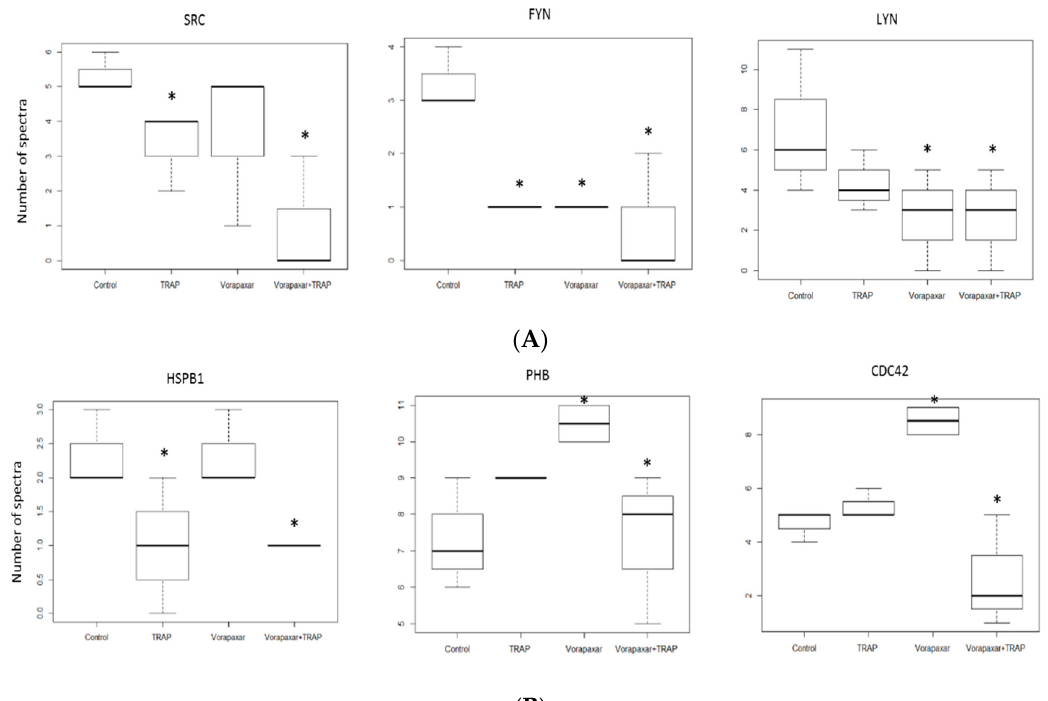
Figure 5. Proteomic analysis of Akt and MAP kinase signaling pathways. ( A ) Akt proteomic analysis showed significant differences in expression level of SRC, FYN, and LYN. * p < 0.05 according to one-way ANOVA test. ( B ) Proteins participating in MAP kinase pathway which showed significant difference between different experimental groups. * p < 0.05 according to one-way ANOVA test. Number of spectra: visualized spectra used to identify peptides and proteins by the X!Tandem search engine. Src: proto-oncogene tyrosine-protein kinase; HSPB1: heat shock protein beta-1; PHB: prohibitin; CDC42: cell division control protein 42.